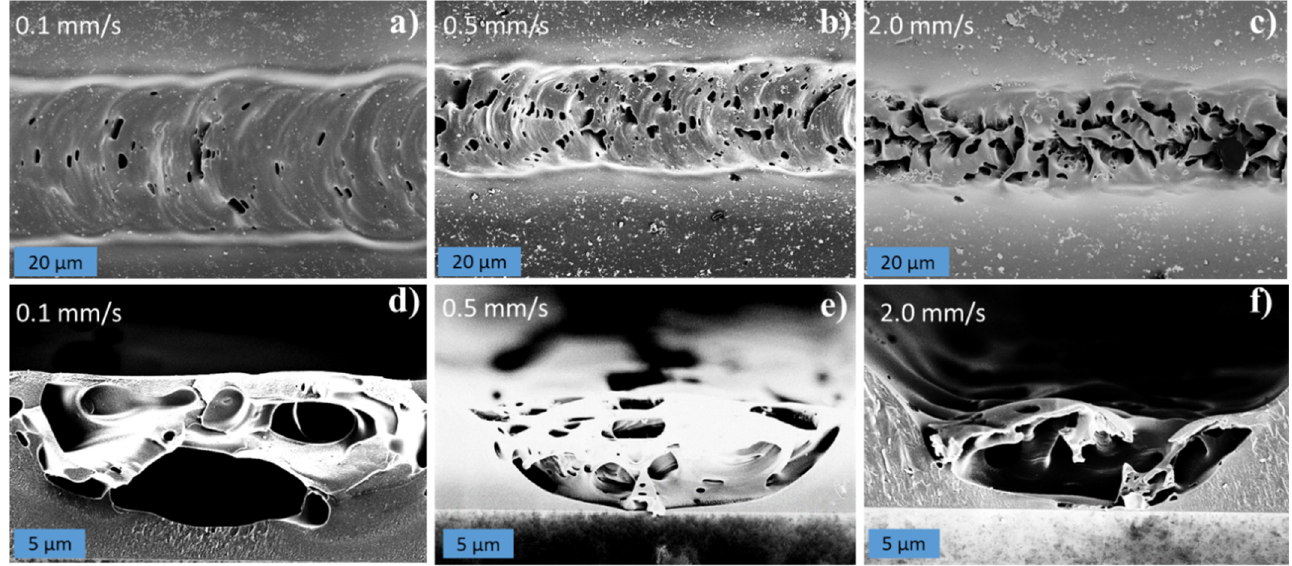
Figure 11. SEM images of ( a – c ) top view and ( d – f ) cross-sections of carbonized lines written with different scan speeds (power 80 mW, 2 scans). The lines in ( a – c ) were scanned from right to left.